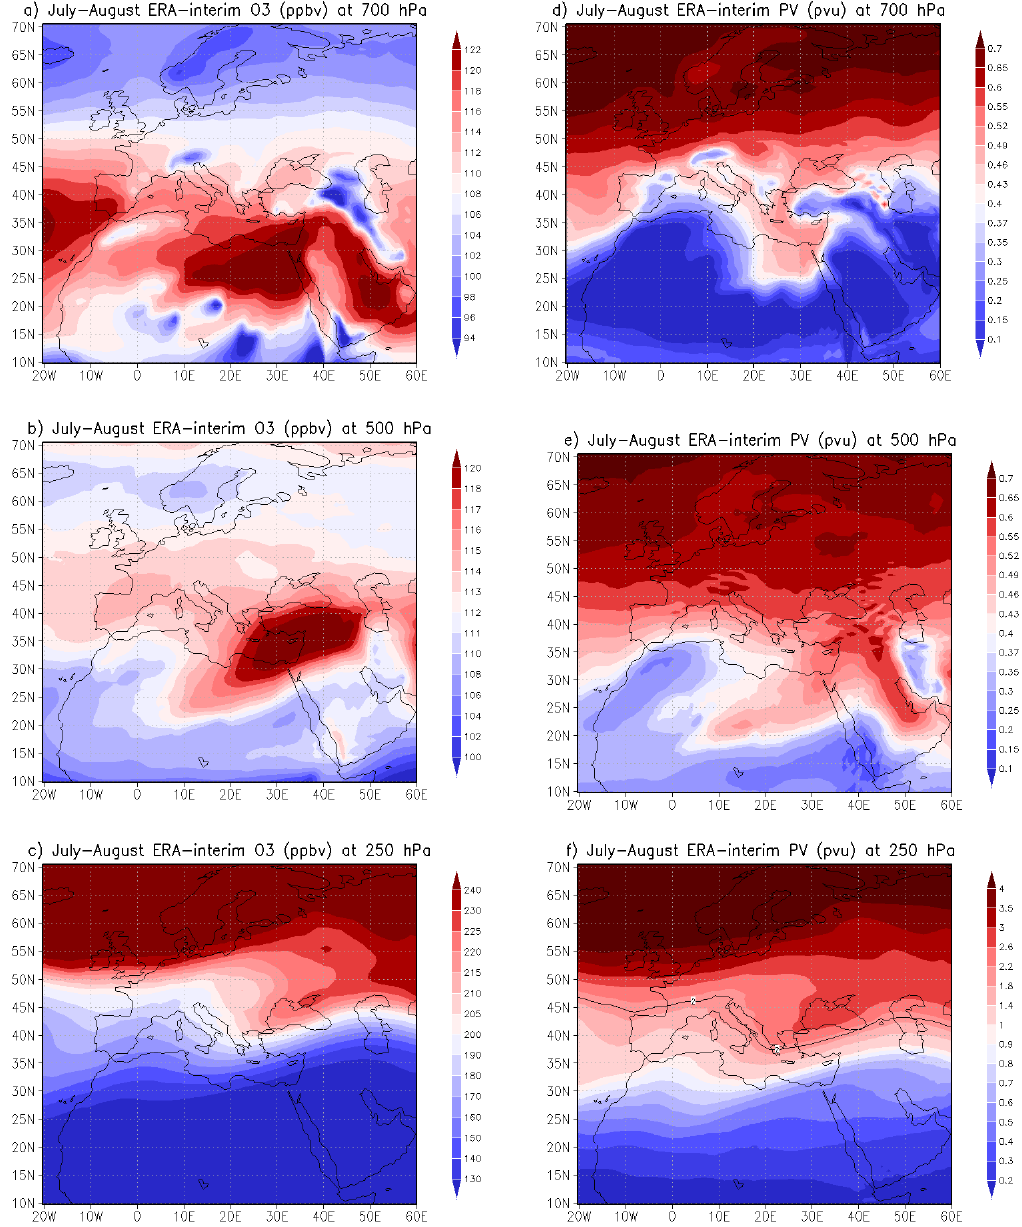
Fig. 4. ERA-Interim July–August average fields of ozone (ppbv), potential vorticity (pvu), specific humidity (gkg − 1 ) and vertical velocity Figure 4. ERA-interim July-August average fields of ozone (ppbv), potential vorticity 889 (Pas − 1 ) over the period 1998–2009 at 700hPa (a, d, g, j) , at 500hPa (b, e, h, k) and at 250hPa (c, f, i, l) , respectively. The vectors in (j) , (k) and (l) denote the horizontal vectors based on the zonal and meridional wind components, while the contour lines indicate the respective (pvu), specific humidity (g/kg) and vertical velocity (Pa/s) over the period 1998-2009 890 average values of horizontal divergence (10 − 5 s − 1 ) at 700 hPa (a, d, g, j), at 500 hPa (b, e, h, k) and at 250 hPa (c, f, i, l), respectively. 891 The vectors in j), k) and k) denote the horizontal vectors based on the zonal and 892 meridional wind components while the contour lines indicate the respective average 893 values of horizontal divergence (10 -5 s -1 ). 894